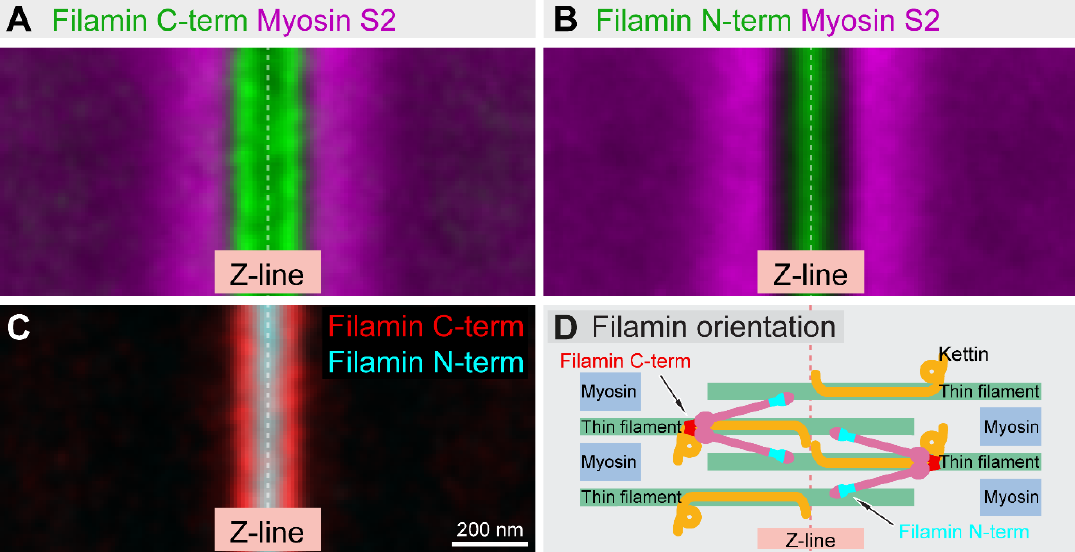
Figure 8. Sarcomeric localization and orientation of Filamin revealed by dSTORM microscopy. ( A ) A Filamin C-terminus- specific antibody revealed a double-line distribution along the edges of the Z-disk separated by roughly 100 nm. ( B ) In contrast to this, the N-terminus-specific antibody displayed a ‘band-type’ distribution in the middle of the Z-disk. ( C ) The aligned representation clearly demonstrates that we can distinguish between the two epitopes, and we can unambiguously determine the orientation of the molecule within the Z-disk. ( D ) Schematic shows the position and orientation of the Filamin dimers in the Z-disk of Drosophila IFM sarcomeres.